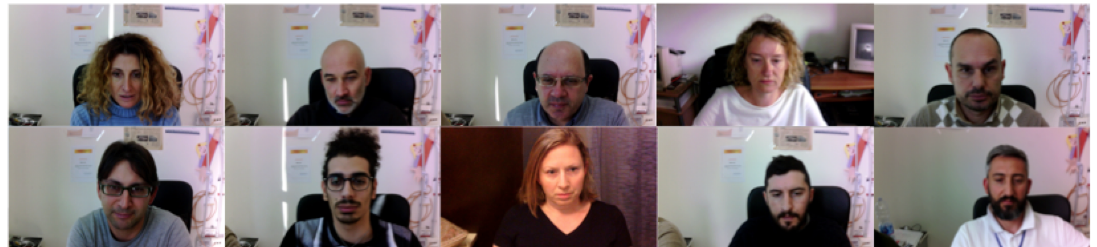
Figure 2. Ten frames with different subjects of the UserWGaze